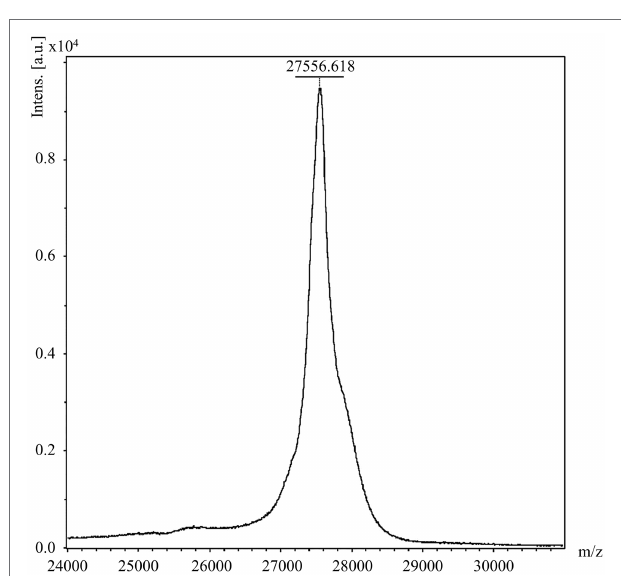
FIGURE 3 | Determination of molecular weight of His 6 -PcaHG98e04 by LC– MS. The mass spectrum of the 27556.618 Da His 6 -PcaHG98e04-PCDS protein detected using the Full MS Scan range from 500 to 5,000